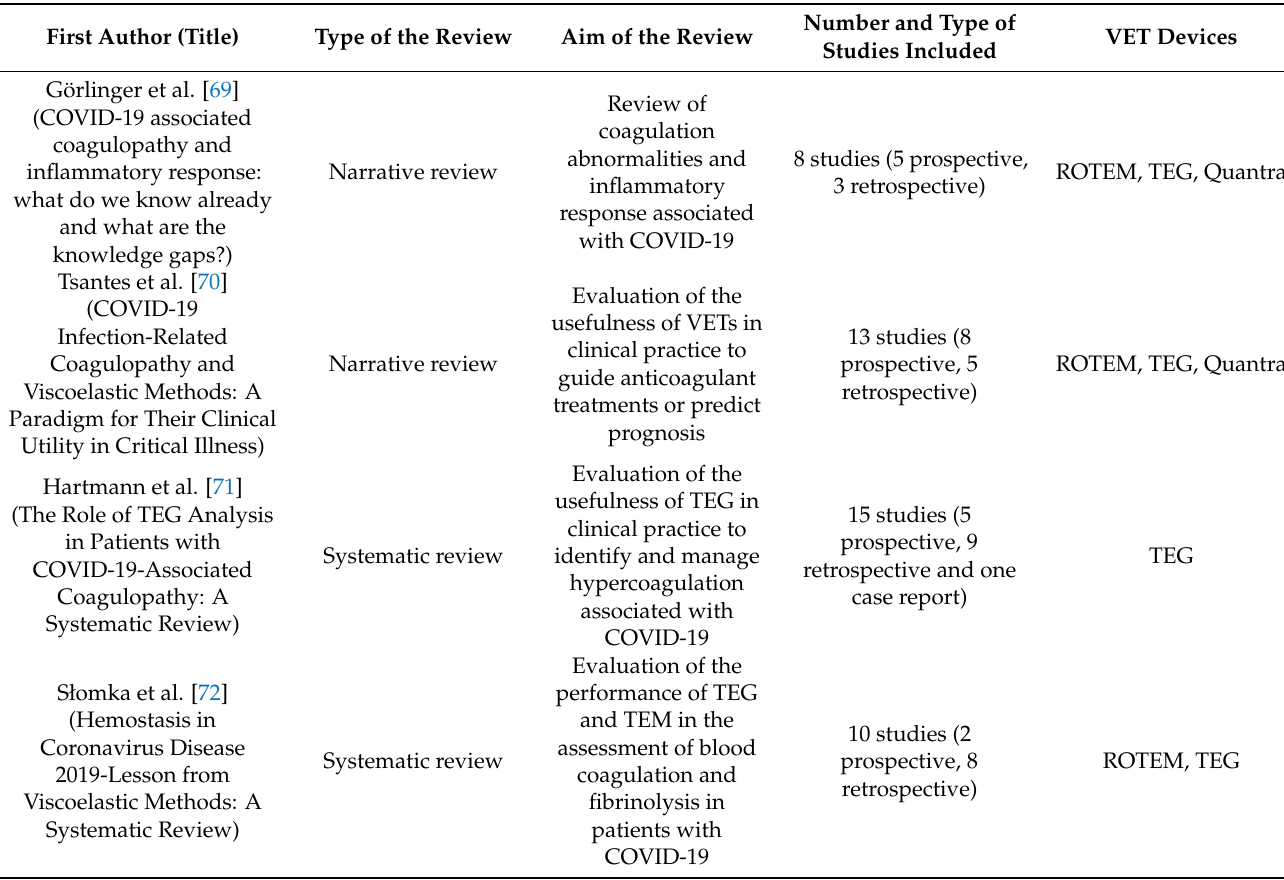
Table 2. Characteristics of the reviews already